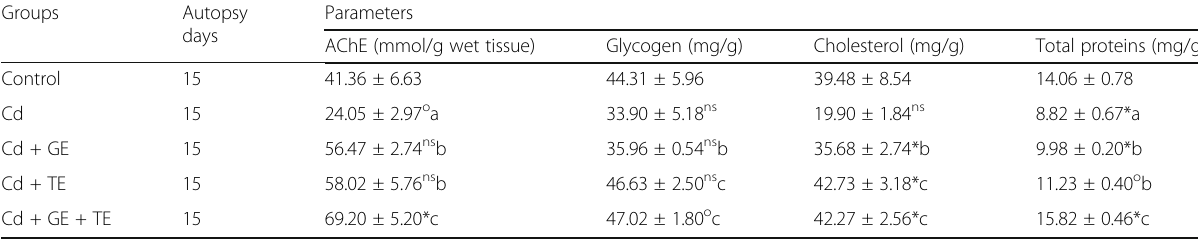
Table 1 Protective effects of garlic and tomato against cadmium (Cd)-induced biochemical parameters in mice at 15 days